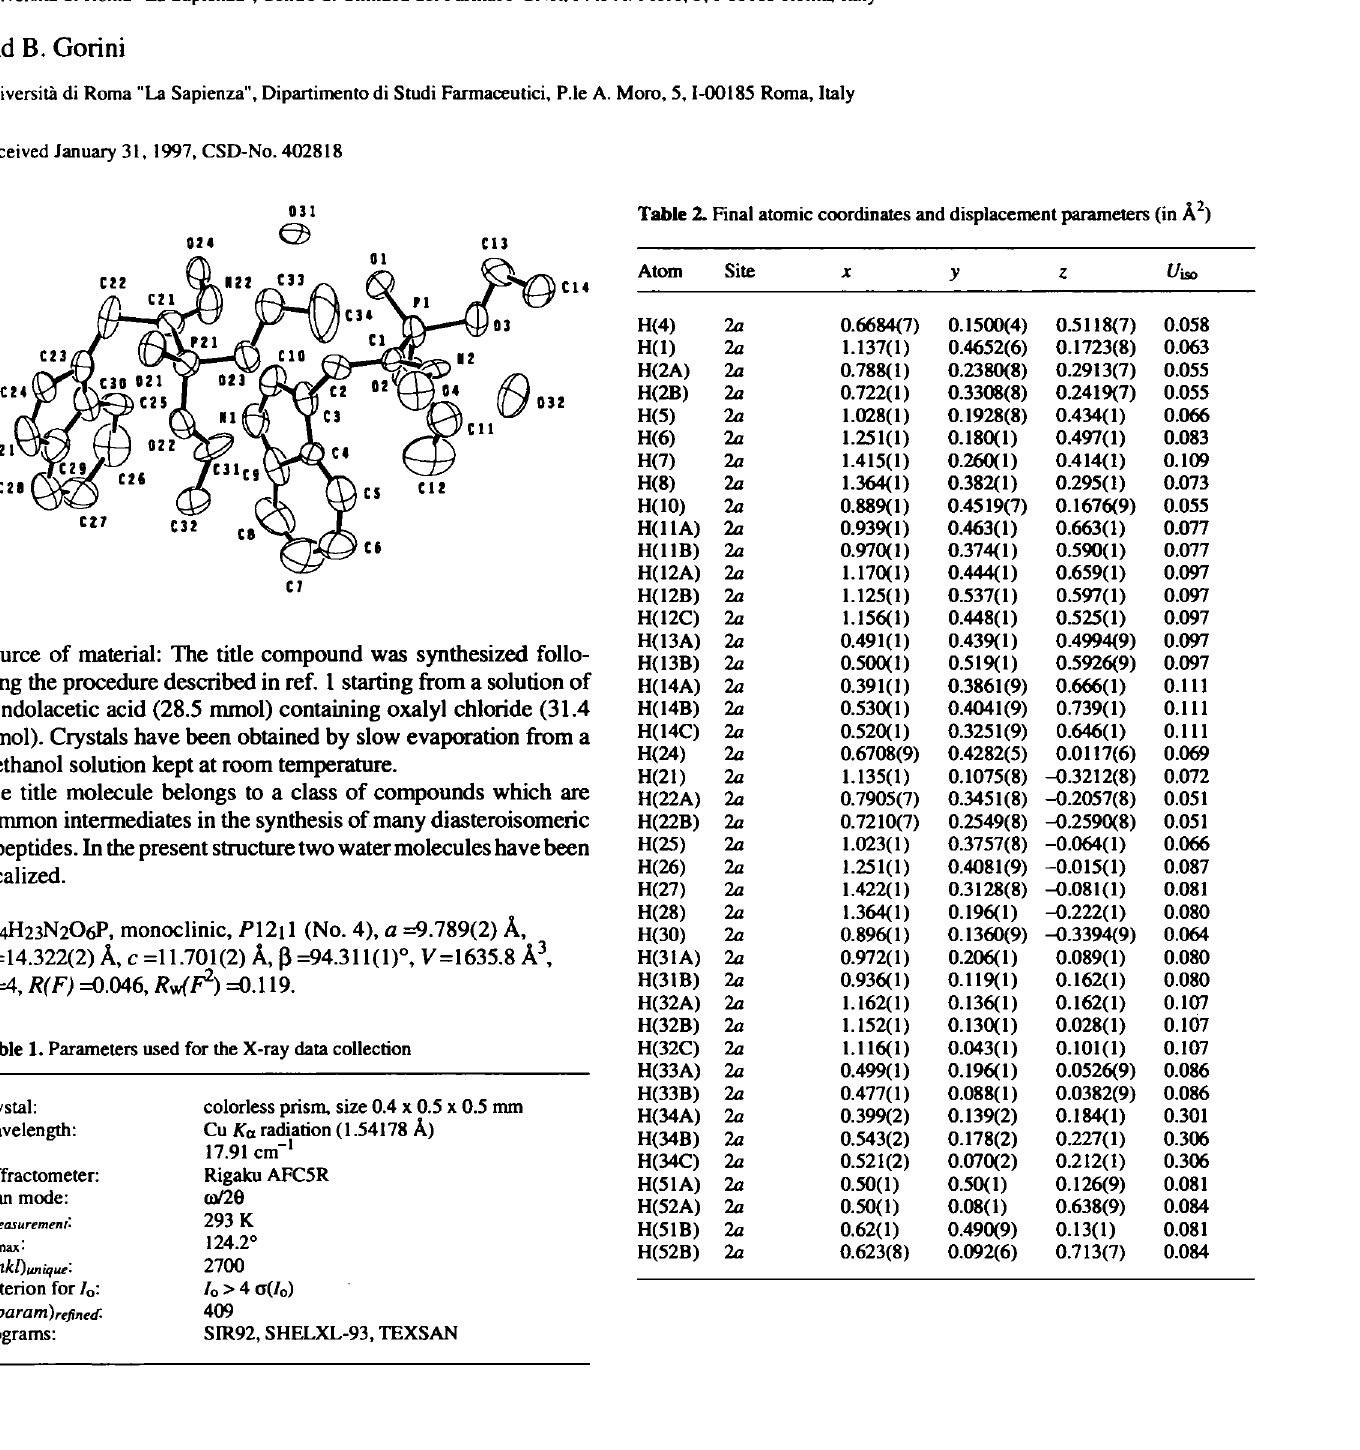
Table 2. Final atomic coordinates and displacement parameters (in